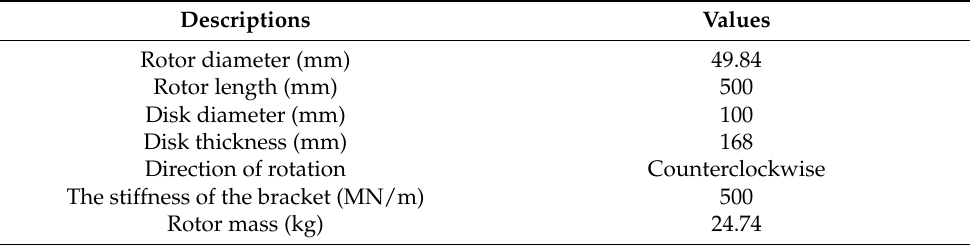
Table 1. Technical specification of the rotor rig.